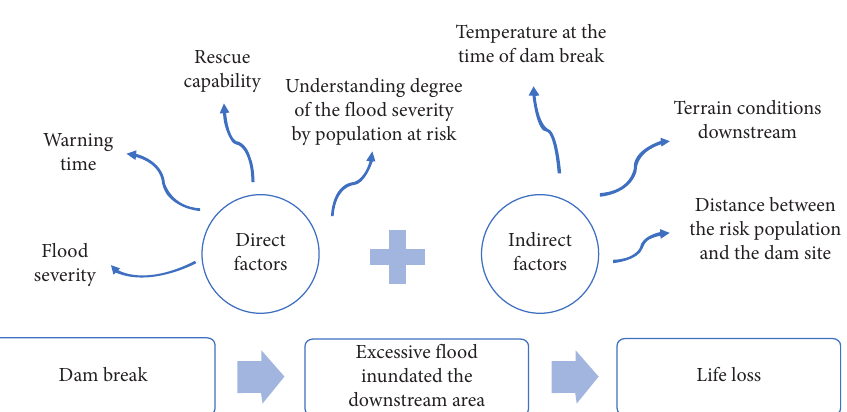
Figure 2: Influential factors of the life loss in a dam-break